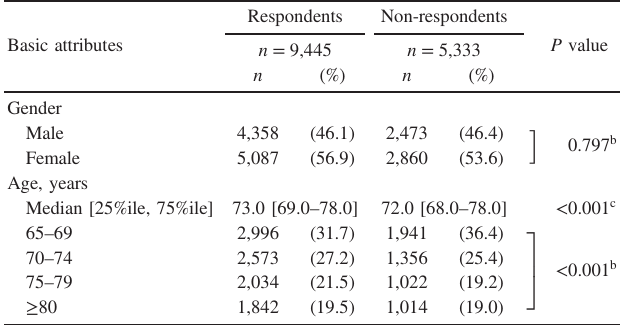
Table 1. Basic attributes of respondents and non-respondents